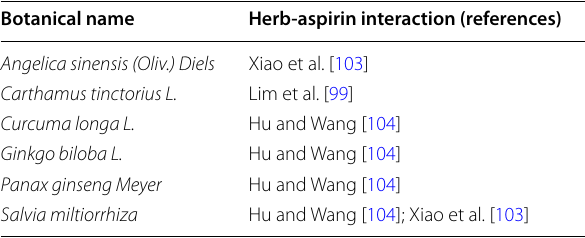
Table 4 List of herb-aspirin interaction causing increased risk of bleeding